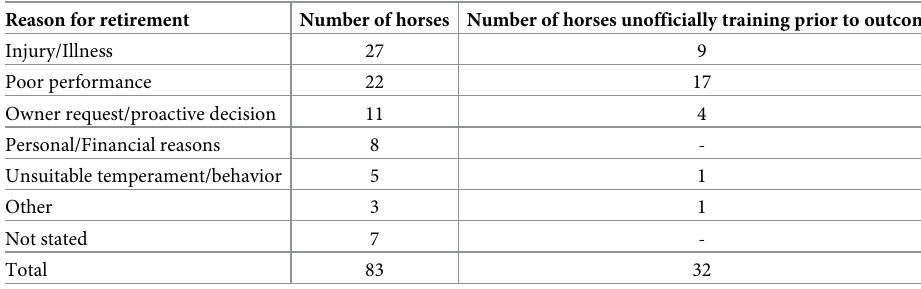
Table 4. Reasons for rehoming/retirement.